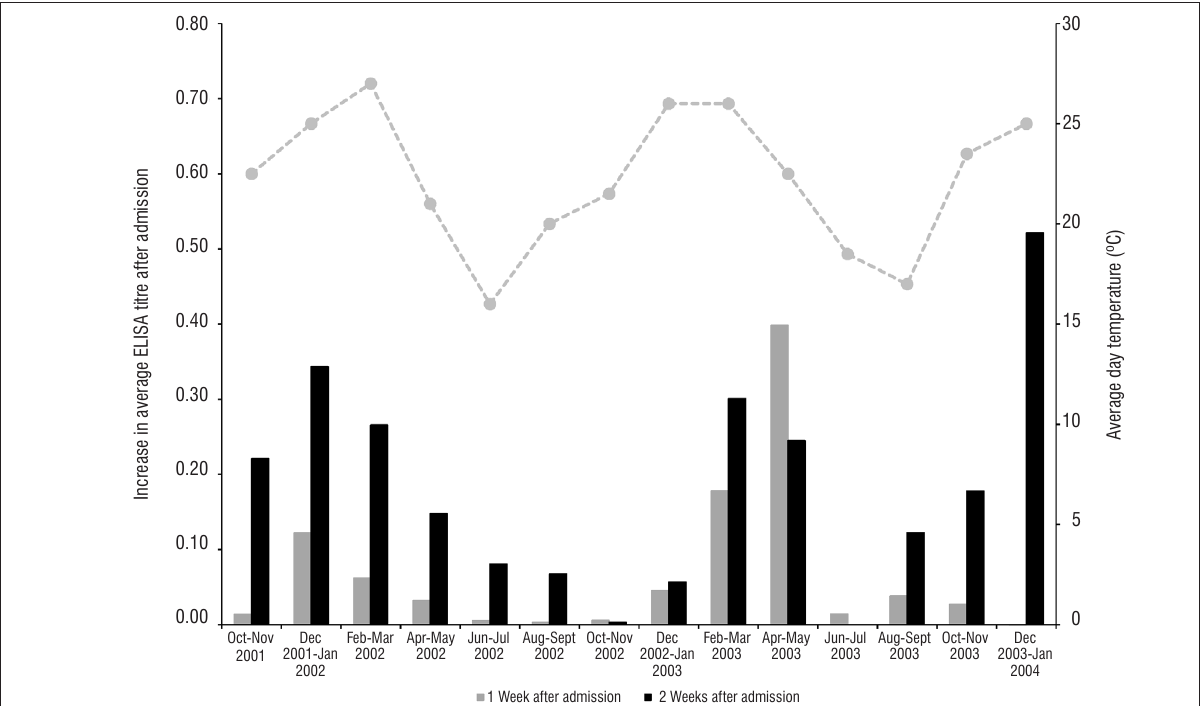
Figure 1: Increases in anti- Plasmodium antibody levels in the weeks after entry into the SANCCOB facility: ‘1 Week after admission’ represents the difference in average ELISA titre values from Week 0 to Week 1; ‘2 Weeks after admission’ represents the difference in average ELISA titre values from Week 0 to Week 2. The temperature is the average maximum values for a given 2-month